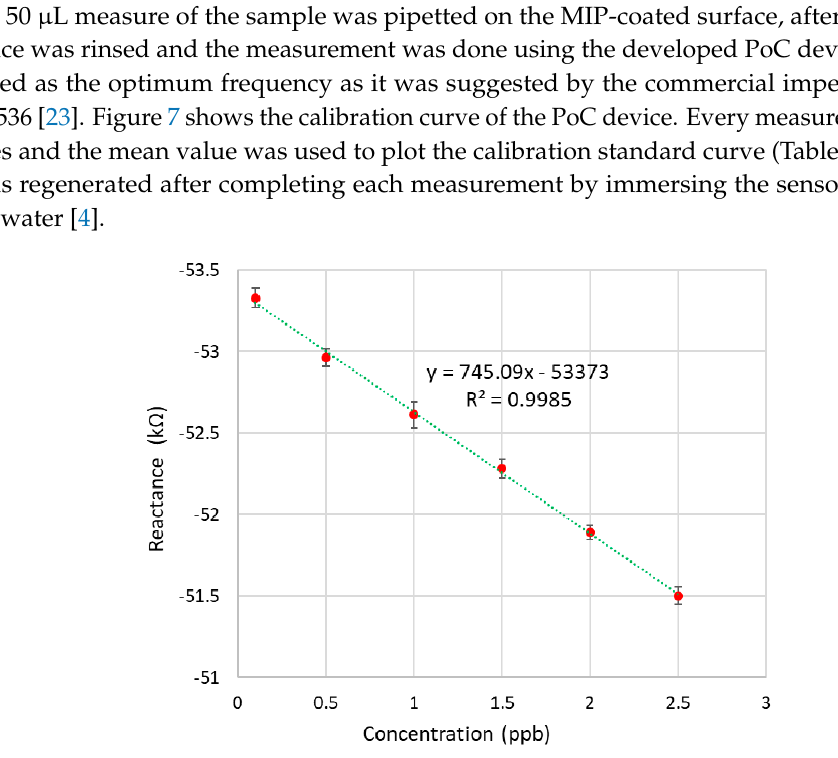
Figure 7. Calibration curve of the PoC system. Table 1. The mean value of reactance and standard deviation for different concentrations of CTx-I. CTx-I Concentration